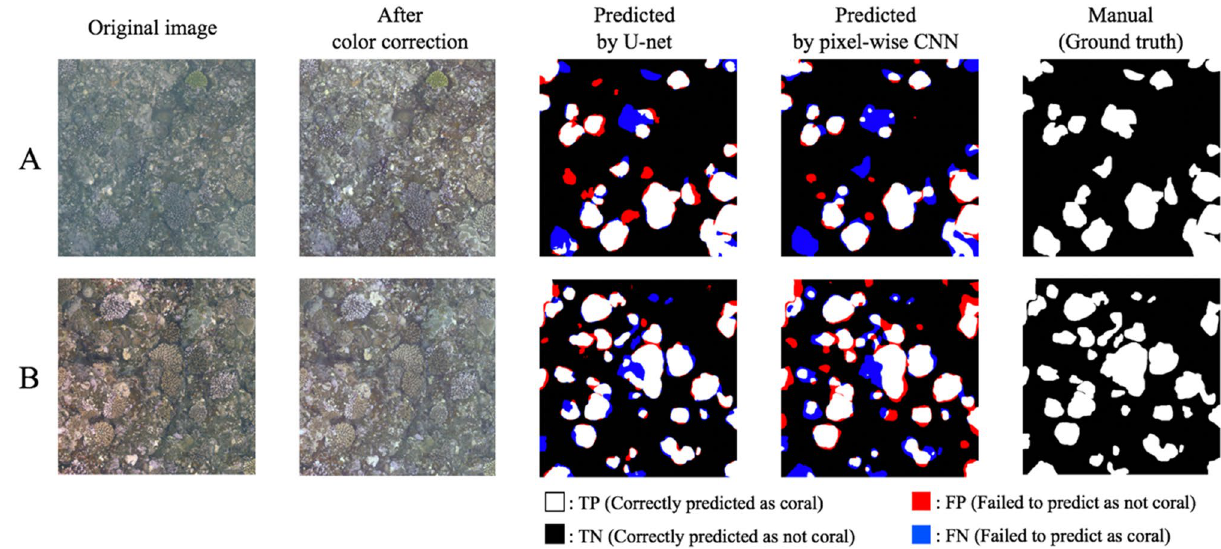
Figure 6. Prediction examples by U-Net and pixelwise CNN. The images in the leftmost column are original images; the second column comprises images processed by color labeling; the third and fourth columns are